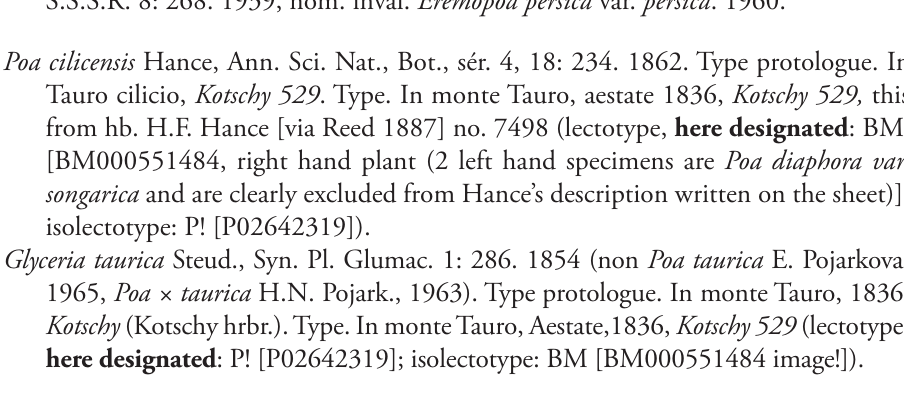
Fig. 3B, C Eremopoa persica var. typica Grossh., Trudy. Bot. Inst. Azerbaidzh. Fil. Akad. Nauk. S.S.S.R. 8: 268. 1939, nom. inval. Eremopoa persica var. persica . 1960. Poa cilicensis Hance, Ann. Sci. Nat., Bot., sér. 4, 18: 234. 1862. Type protologue. In Tauro cilicio, Kotschy 529 . Type. In monte Tauro, aestate 1836, Kotschy 529, this from hb. H.F. Hance [via Reed 1887] no. 7498 (lectotype, here designated : BM!